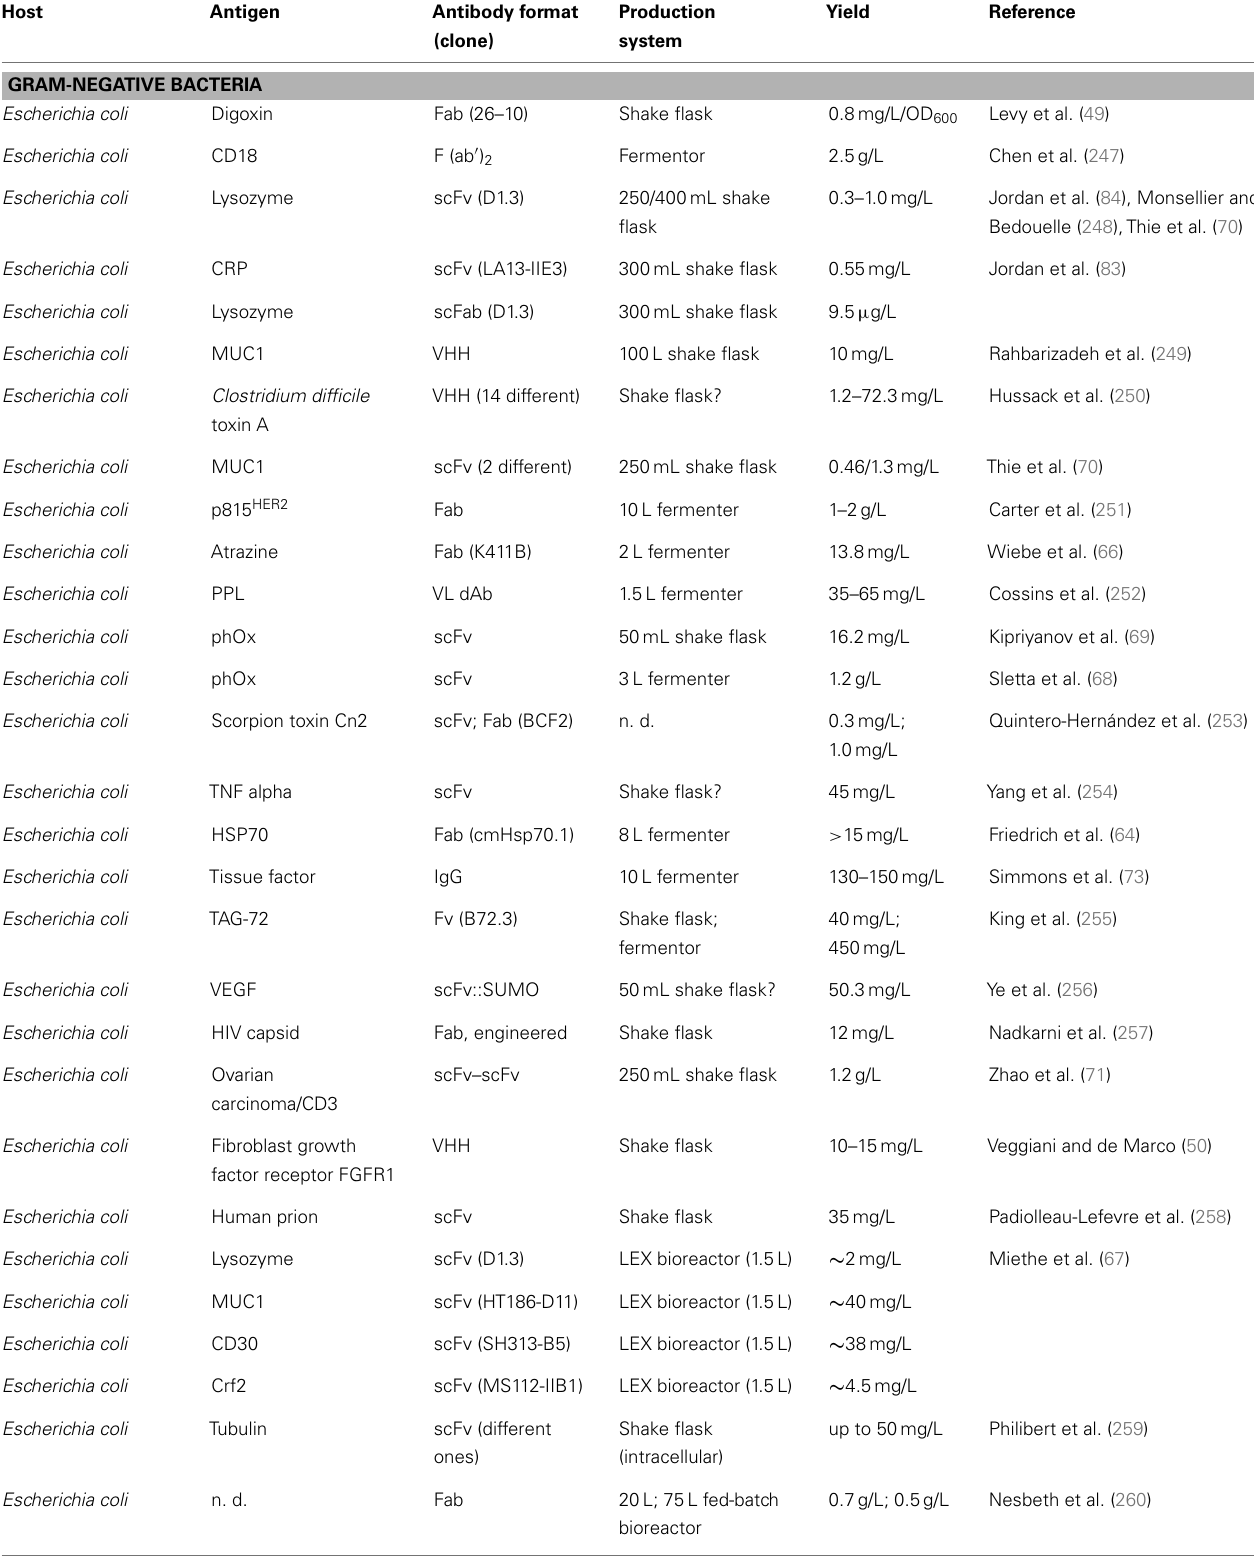
Table 1 | Production of recombinant antibodies by